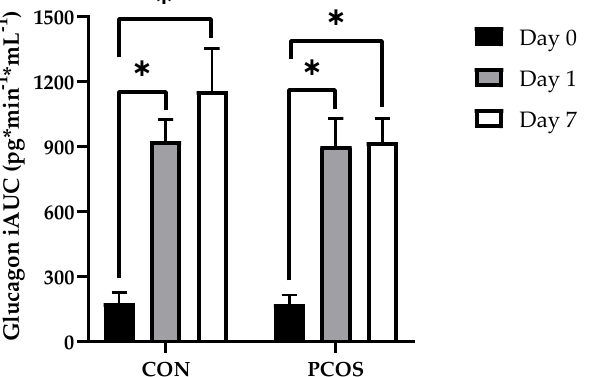
Figure 9. Glucagon iAUC mean values ( ± SE) in CON ( n = 14) and PCOS ( n = 15). * = significance between days, p < 0.05. CON = non-PCOS women; iAUC = incremental area under the curve; PCOS = women with polycystic ovarian syndrome.